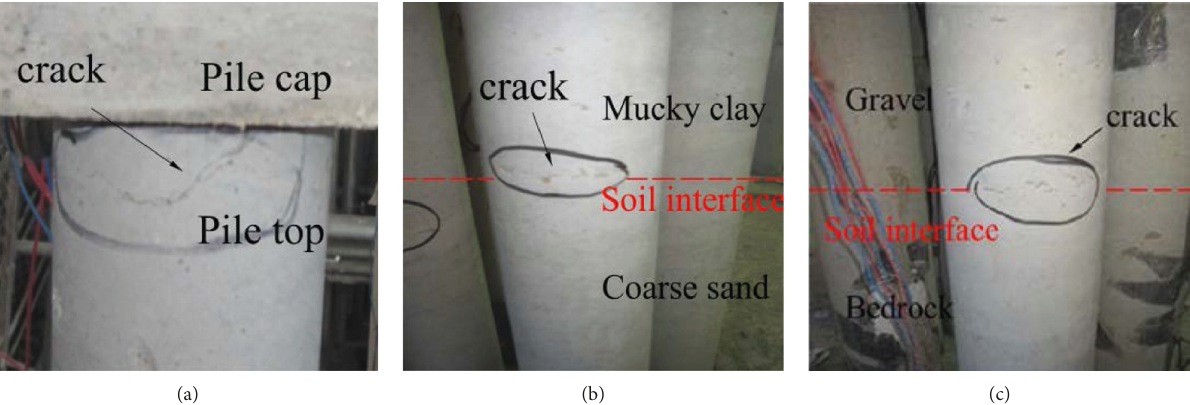
Figure 19: Pile crack damage: (a) the junction of the top of the pile and the cap; (b) soft-hard soil interface; (c) bedrock